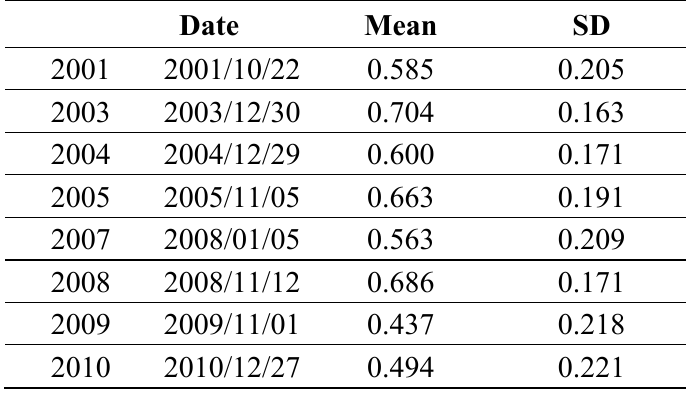
Table 1. Mean and standard deviation of NDVI maps during